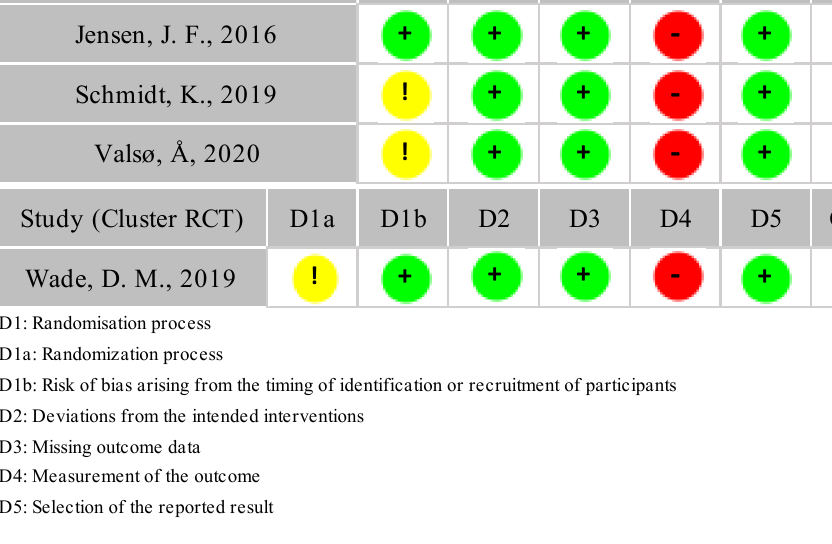
Figure 2. Risk of bias for PTSD.